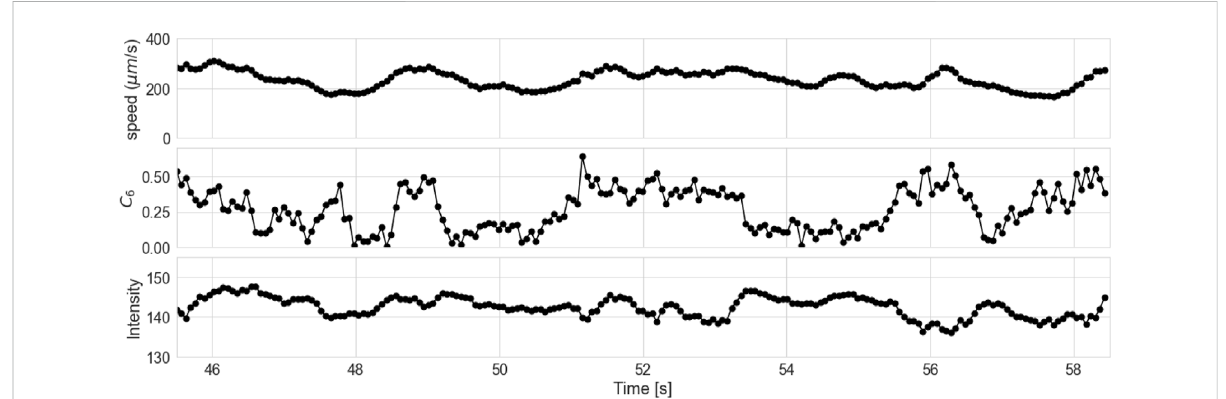
FIGURE 6 Section of time series of speed, hexagonal order, and intensity generated from kymographs at applied stress 20 Pa and height 10 μ m . The fi rst eight data points correspond to the image shown in Figure 5 (middle).